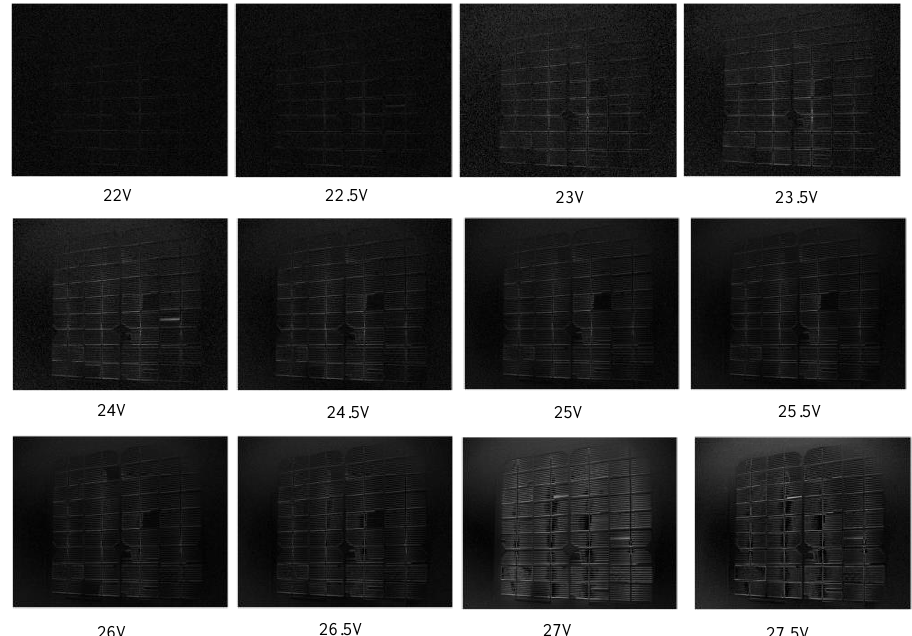
Figure 13. Images I of monocrystalline silicon photovoltaic panel with bias voltages.